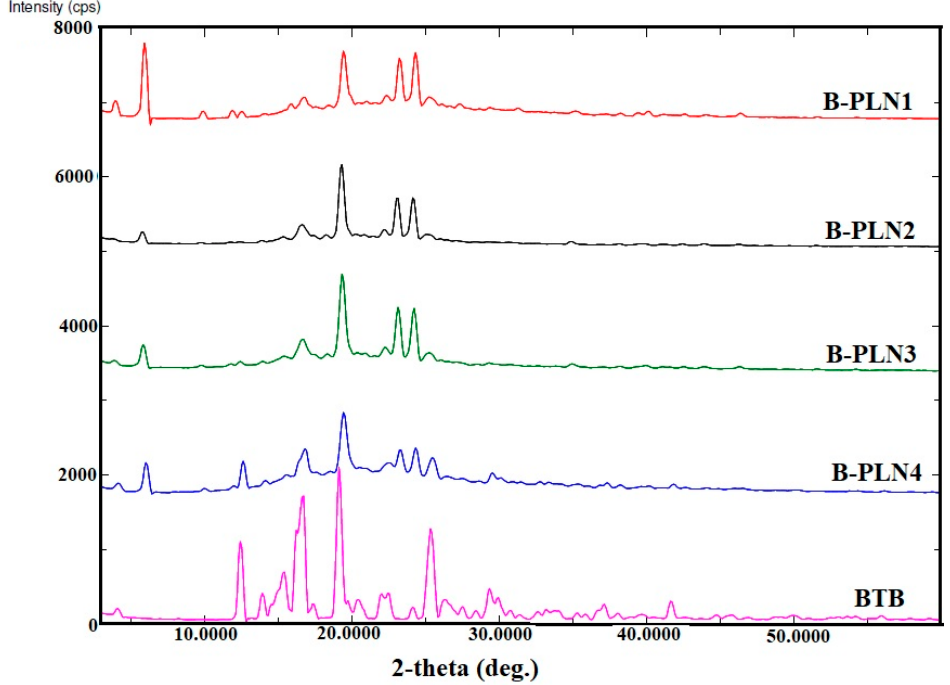
Figure 3. XRD spectra of BTB and formulated lipid-polymer nanoparticles (B-PLN1-B-PLN4).